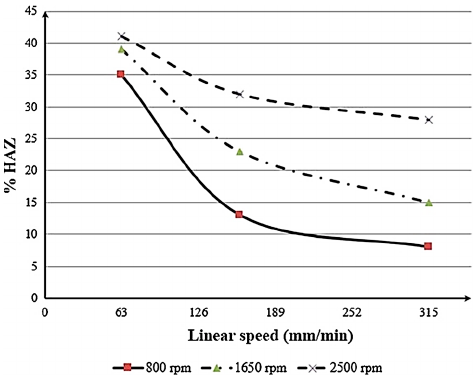
Figure 5. The effect of rotational and linear speed (traverse speed) on the size of HAZ in the FSW of AA5052-H18 [103]. Reprinted from: Friction Stir Welding of 5052-H18 aluminum alloy: Modeling and process parameter optimization." Journal of Materials Engineering and Performance 30 (2021): 1838–1850, Mohammadi Sefat, Mohammad Javad, Hadi Ghazanfari, and Carl Blais. Copyright 2021, with permission from Springer Nature. Table 2. A summary of selected optimization parameters reported achieving high tensile properties in FSW joints of non-heat-treated Al alloys . Optimum Parame- Welding Tool Ge- ters Results and Joint Al Alloy Plate Thickness Ref. ometry for Tensile Efficiency % Strength